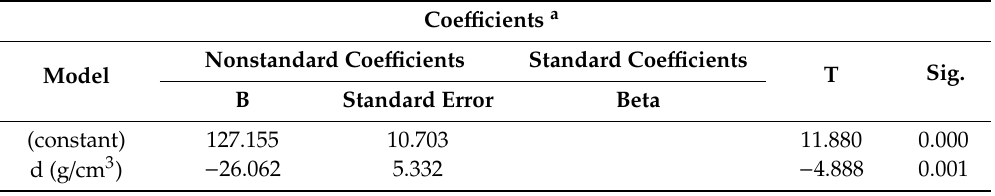
Table 8. Linear regression coe ffi cients: Wheel-tracking test and first modulus of the plate bearing test.